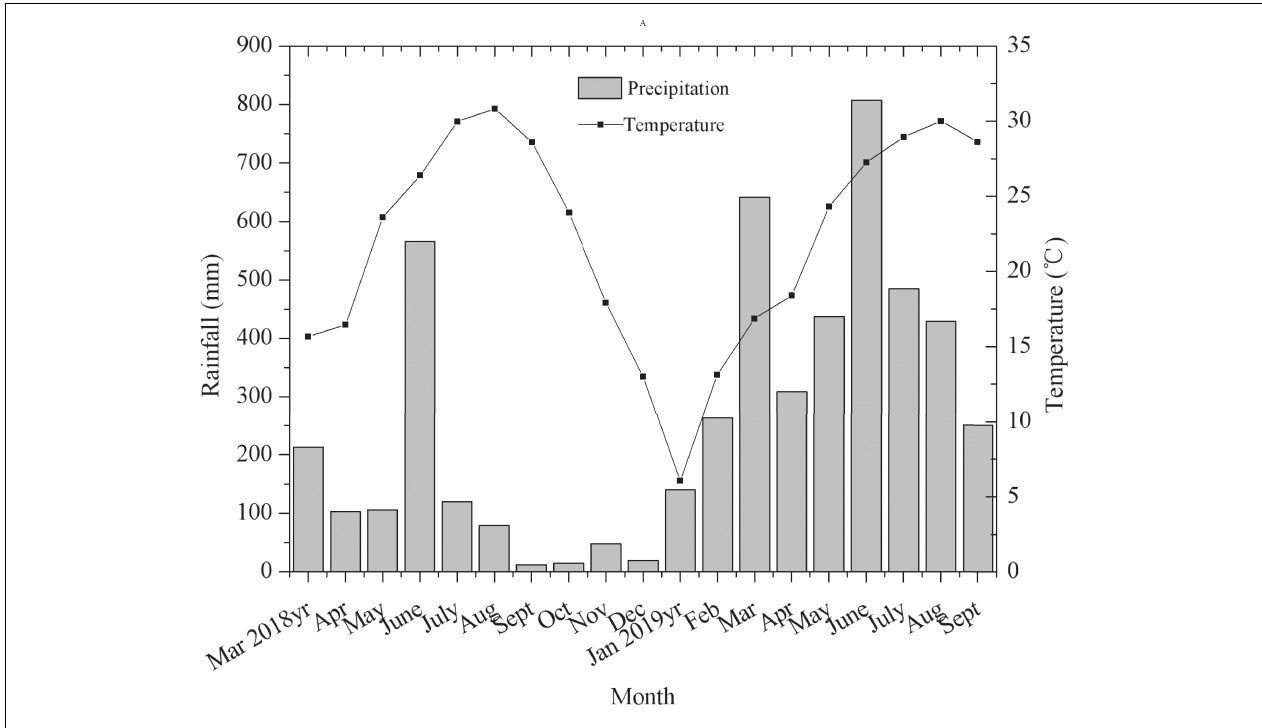
FIGURE 1 | The distribution diagram of the monthly mean rainfall and temperature in the runoff plot from March 2018 to August 2019.